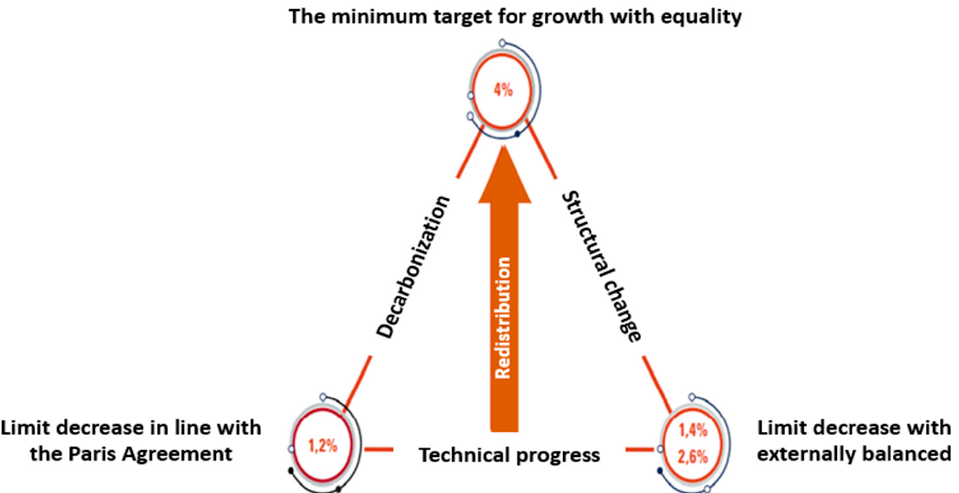
Figure 16. Economic Commission for Latin America and the Caribbean (ECLAC) .